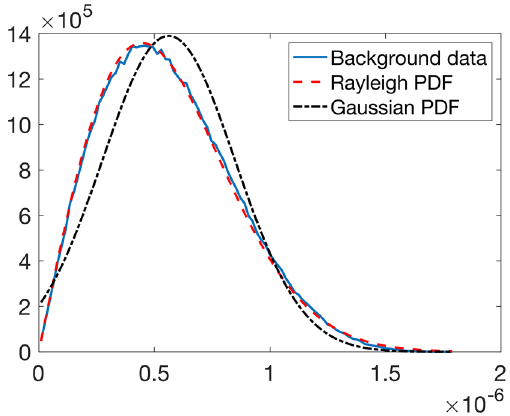
Figure 8. Fit of the background data of image I in Fig. 2 to a Rayleigh distribution. A fit to a Normal distribution is shown for